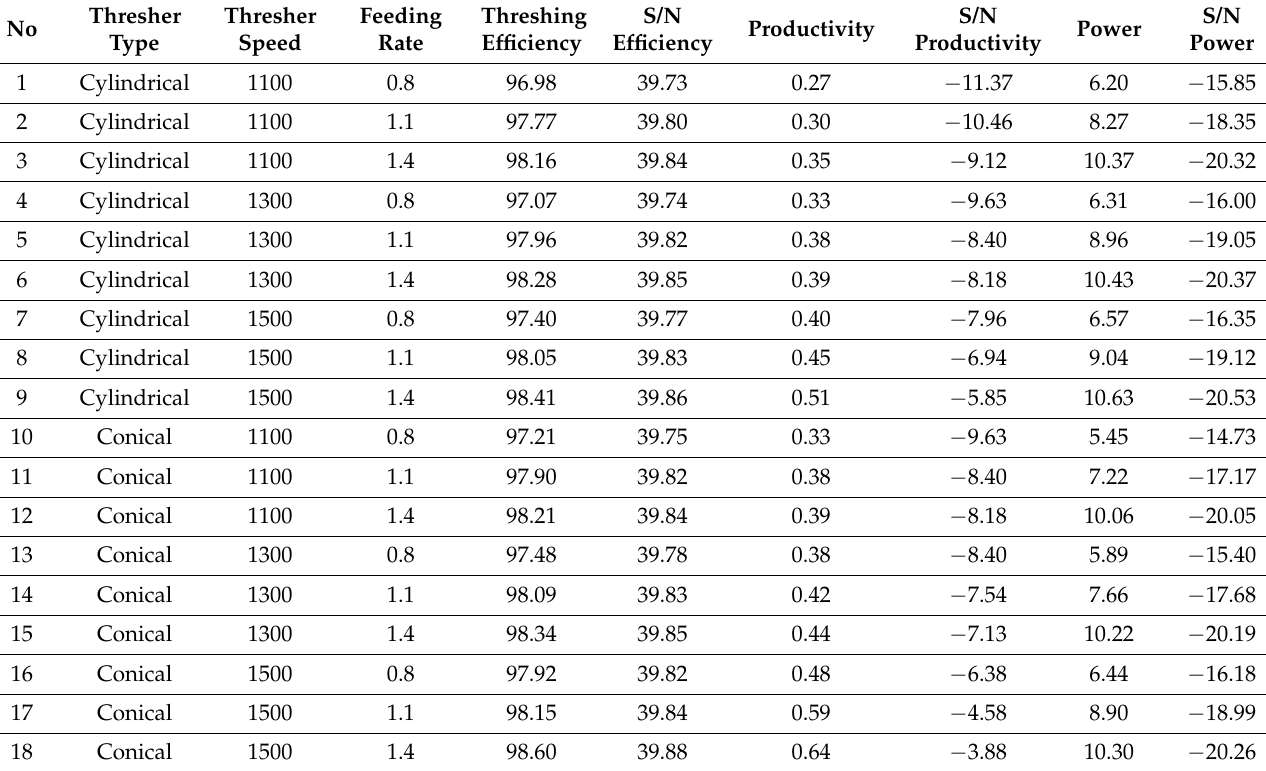
Table 4. The results of experiment and the signal–noise (S/N)